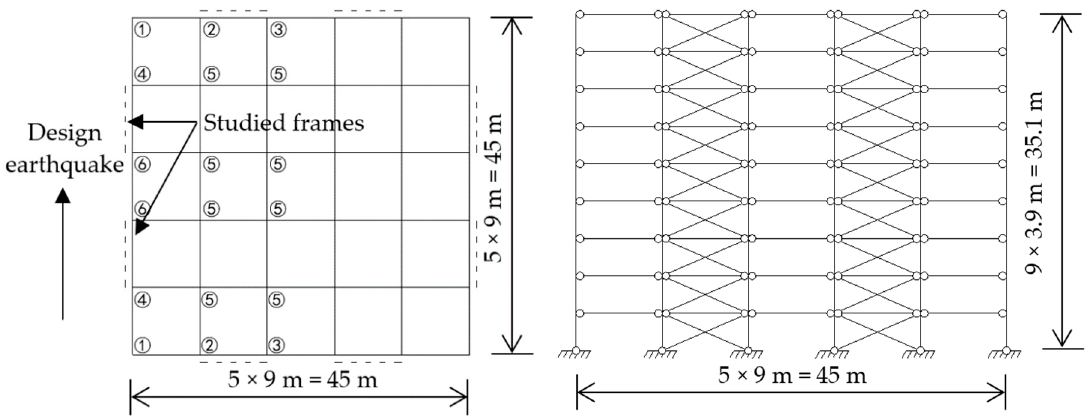
Figure 3. Layouts and load information of the prototype building. Gravity loads: Roof: Dead = 5.0 kPa; Live = 2.0 kPa. Floor: Dead = 4.5 kPa; Live = 4.0 kPa. Exterior walls = 10 kN/m. Seismic load data: